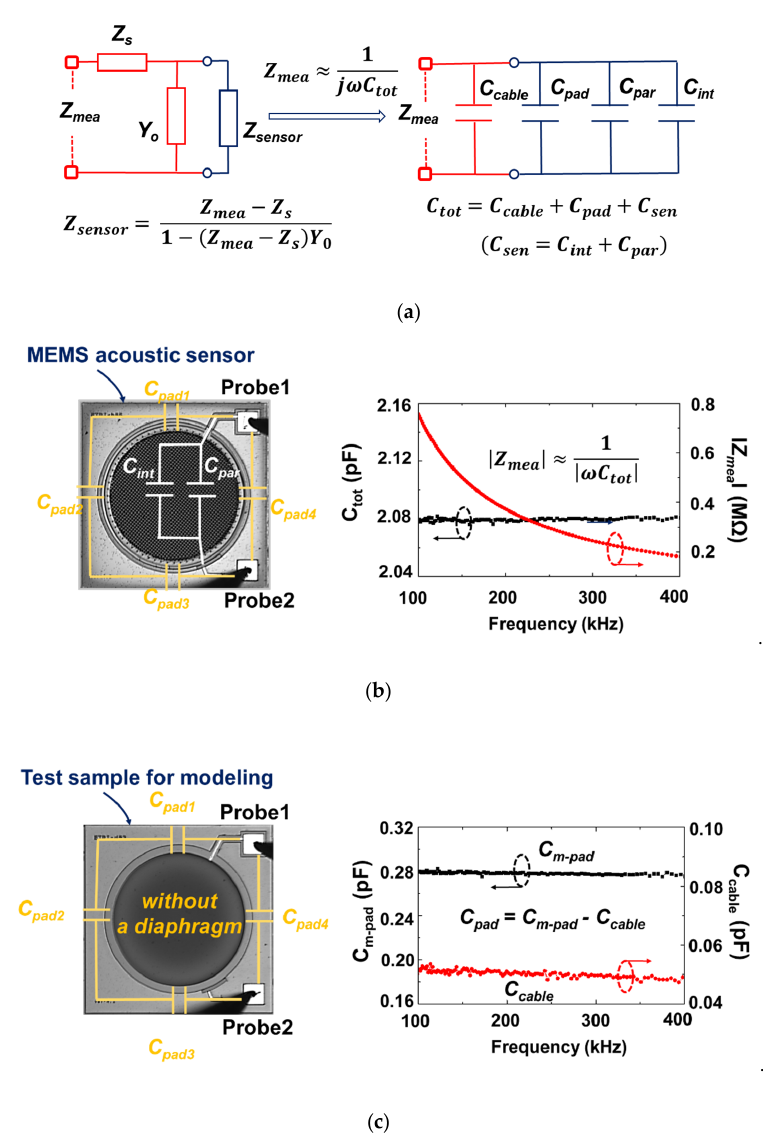
Figure 2. ( a ) The original circuit including the probe effect and the approximately circuit